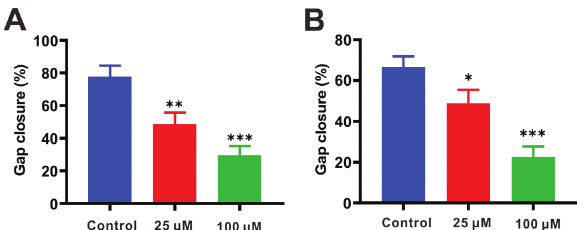
Fig. 2. Geraniol inhibits migration of UM1 and SCC 9 cells in a dose-dependent manner. (A–B) Wound healing assay was carried out to measure the migratory ability of indicated cells. * P < 0.05, ** P < 0.01, and *** P < 0.001, compared with the control